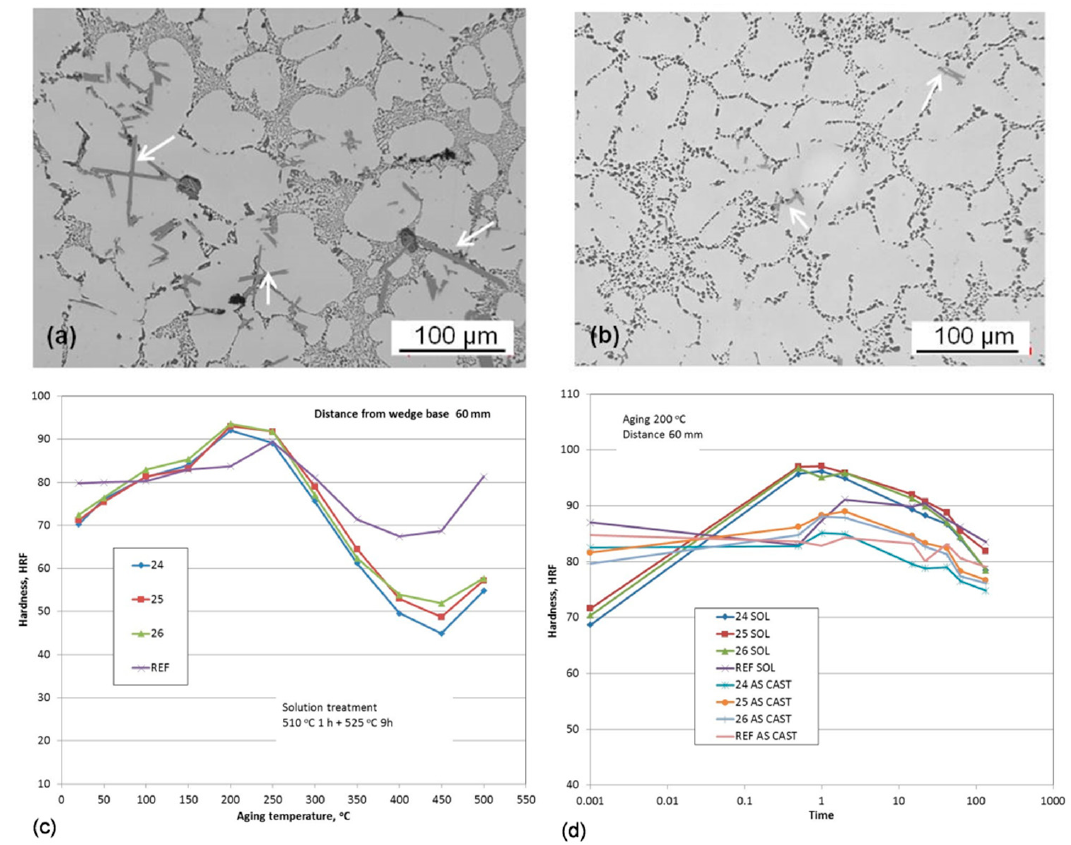
Figure 22. Microstructure of the Al7Si1Cu0.5Mg alloy modified with 0.47 wt.% Zr, 0.21 wt.% Ti, 0.30 wt.% V in as-cast condition ( a ) and after T6 heat treatment (solutionizing 510 ◦ C: 0.5 h + 525 ◦ C, 4.5 h water quench; aging 200 ◦ C, 1 h air cooling). Arrows indicate coarse phases containing transition metals Ti − Zr − V ( b ). Effect of aging temperature ( c ) and time ( d ) on hardness for various additions of transition metals. Figure legend: (24) 0.14 wt.% Zr, 0.14 wt.% Ti, 0.22 wt.% V; (25) 0.42 wt.% Zr, 0.18 wt.% Ti, 0.17 wt.% V; (26) 0.47 wt.% Zr, 0.21 wt.% Ti, 0.30 wt.% V; (REF) A380 alloy.